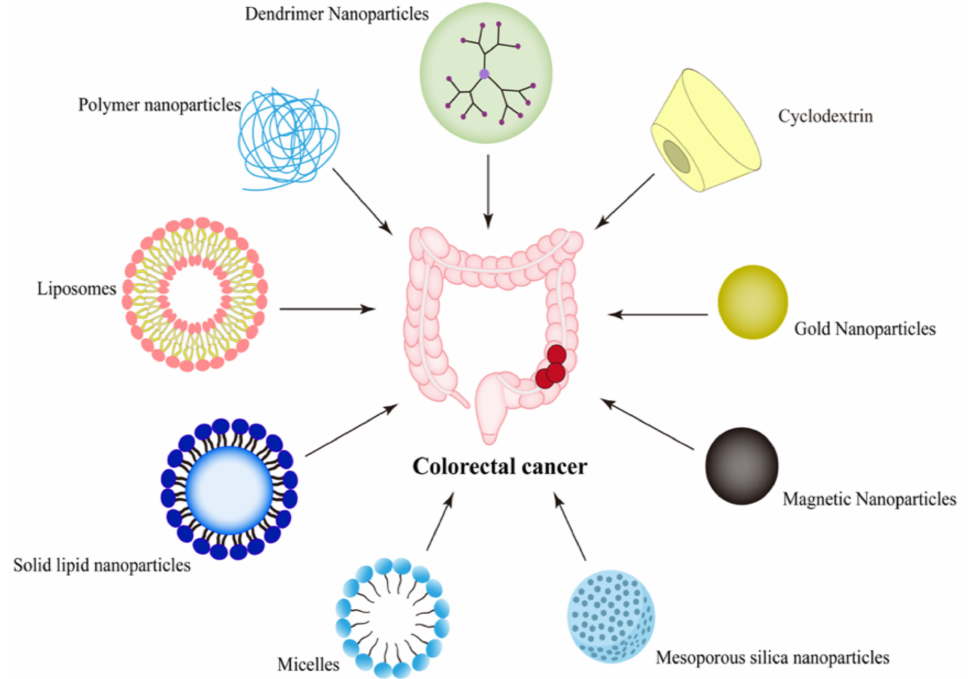
Figure 1. Types of nano-drug delivery systems targeting